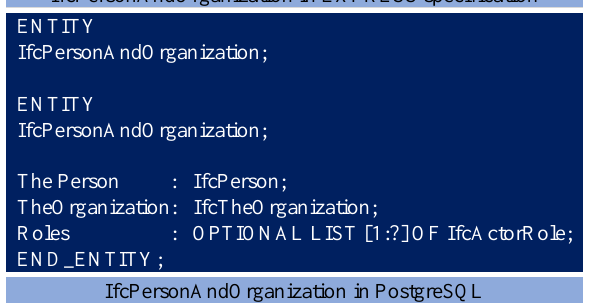
Figure 7: SQL that creates an indicative table of an entity